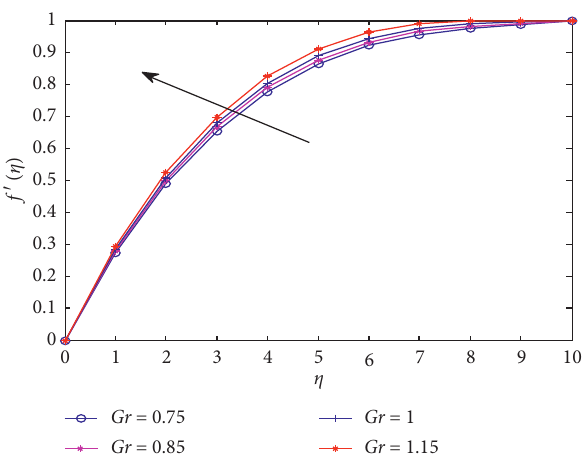
Figure 5: Velocity profiles for various values of the Grashof number ( Gr ) when Pr � 0.72, λ � 0.1, M � 0.1, Ra � 0.1, and Bi �